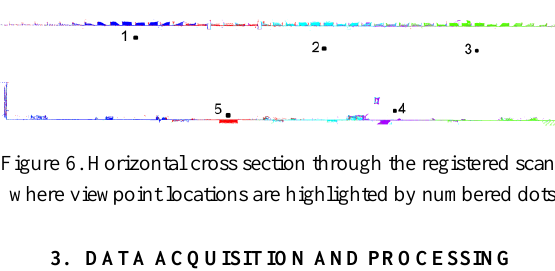
Figure 8. Data acquisition of the